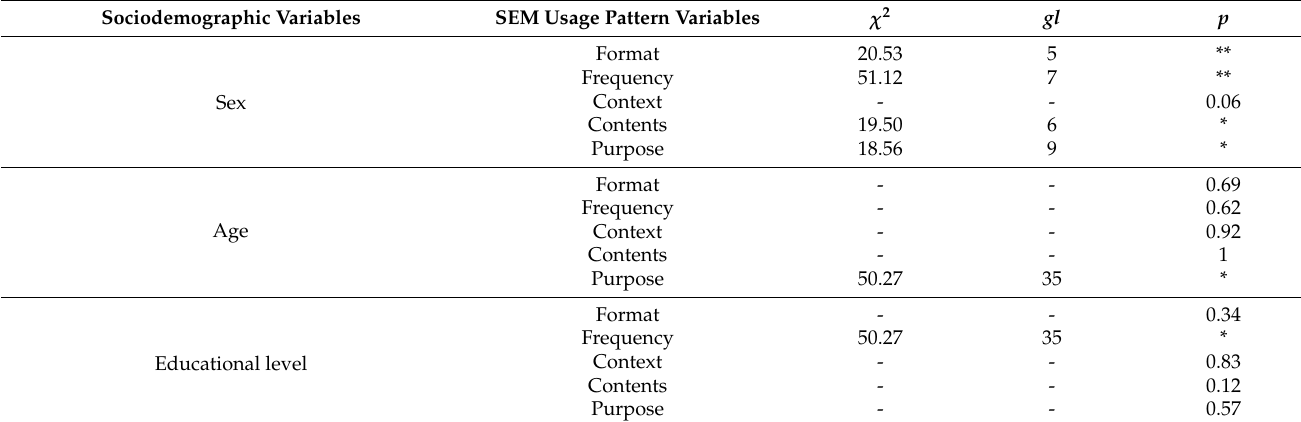
Table 3. Pattern of SEM use based on sociodemographic